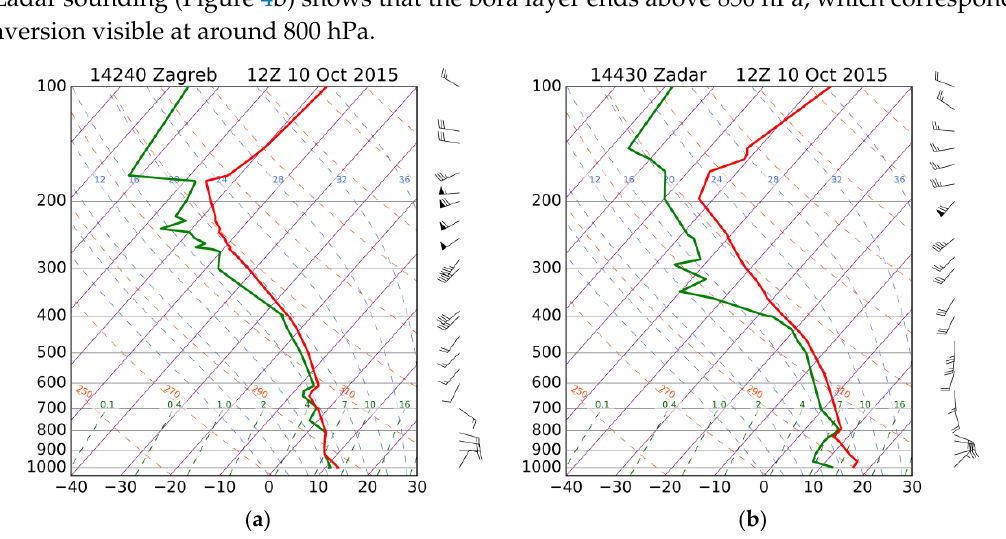
Figure 4. The skew-T log-P graph of sounding data from the Zagreb ( a ) and Zadar ( b ) stations at 12 UTC on 10 October 2015. Bora episode B01 (SC). The vertical axis (pressure) is in hPa and horizontal axis (temperature) is in °C.